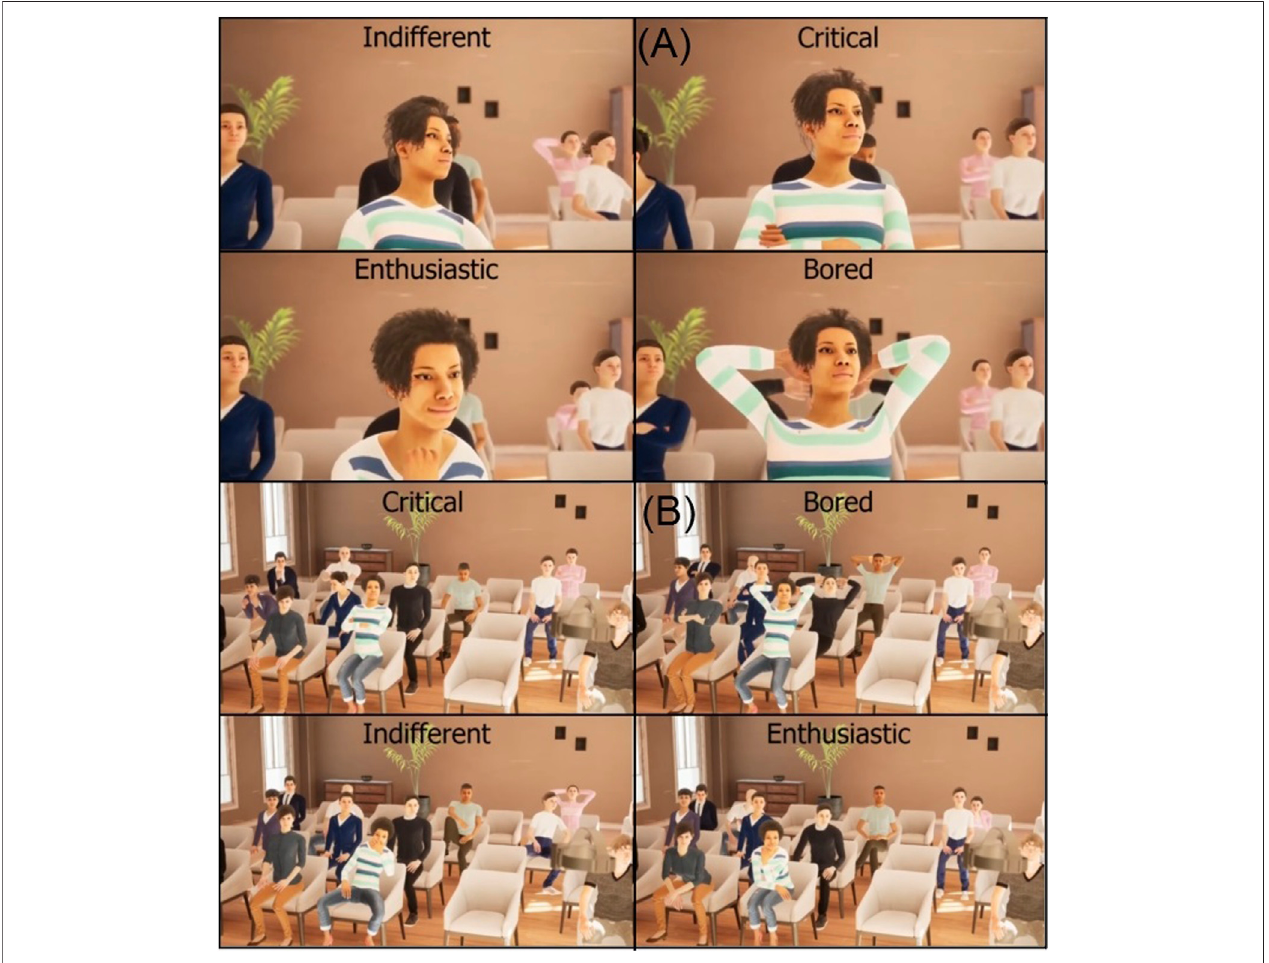
FIGURE 10 | Example of nonverbal behaviors used to display four different attitudes, (A) shows this behaviors on one agent and (B) for the entire virtual audience.